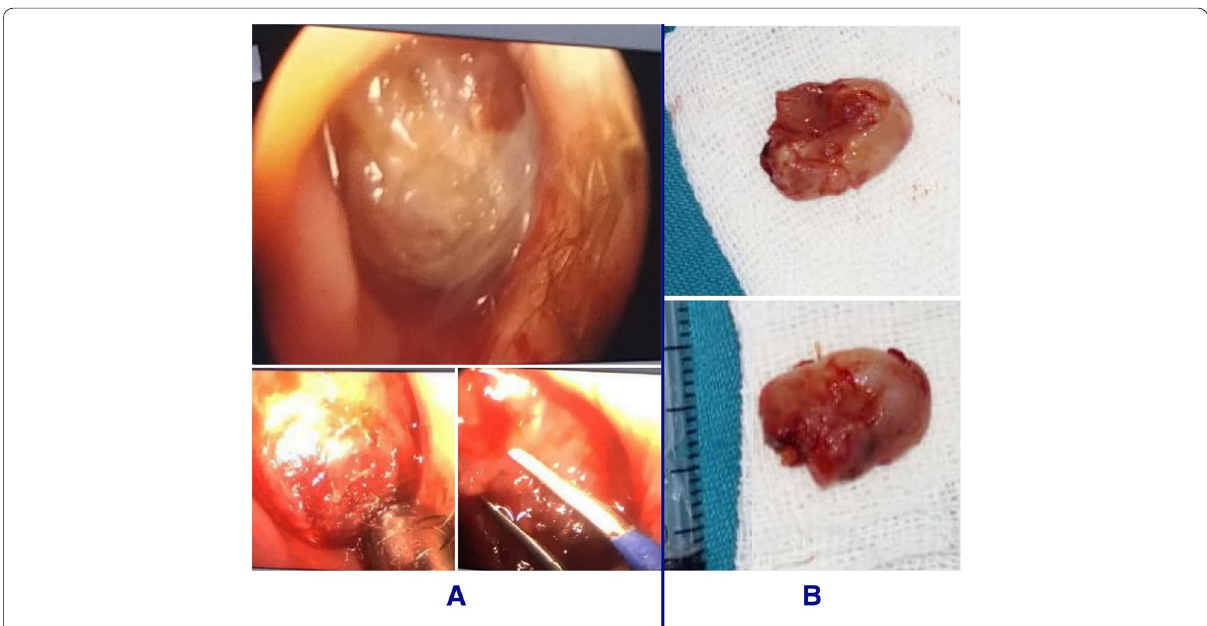
Fig. 2 Surgical excision under general anesthesia and endoscopic guidance. A The formation presented of hard consistency, firmly adhering to the septum and bleeding. It was removed up en bloc to its vascular base. Electrical cauterization was sufficient since the poor vascularity of the lesion allowed for removal without any significant intraoperative blood loss and did not require preoperative embolization. B The pedicle had been completely transected and the mass sent after resection for a histological